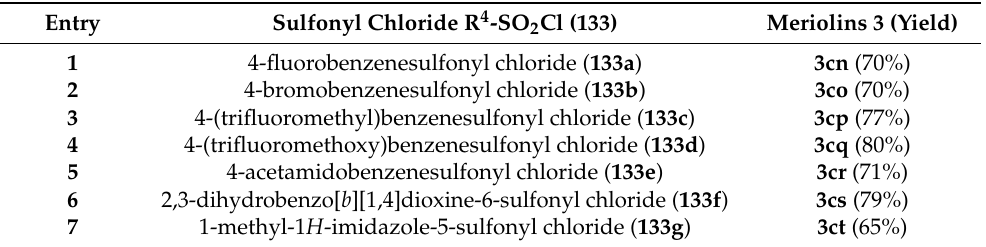
Table 4. Sulfonyl chlorides 133 for the functionalization in N-1 position and the corresponding yields of meriolins 3cn - ct .